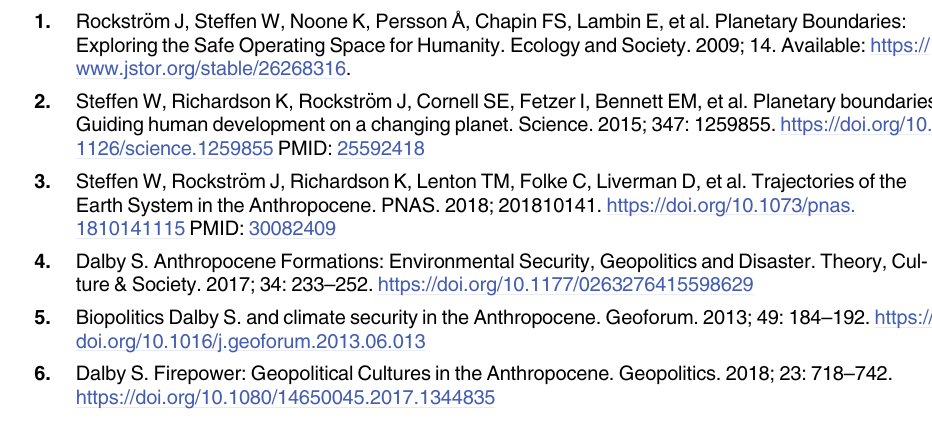
S1 Fig. Results of Spearman’s Rank-Order Correlation Coefficient (r scatterplots for the variables Vulnerability , Eco-health , and Proportion Mortality